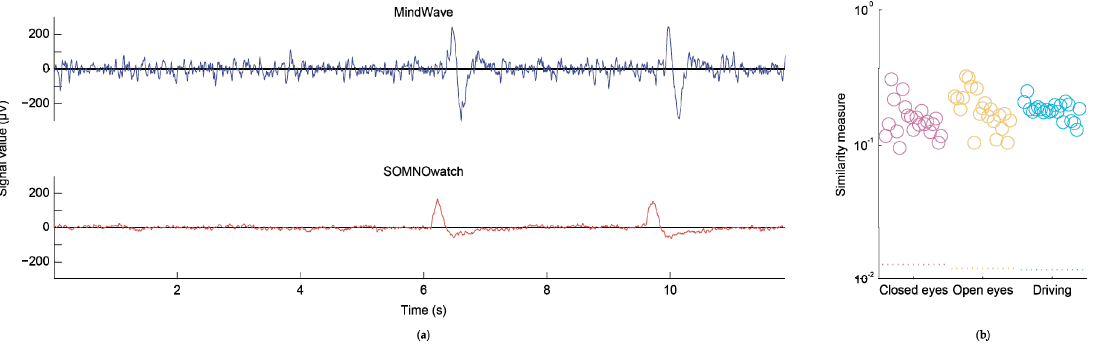
Figure 4. Comparison of temporal data series. ( a ) Left panel shows example traces of a simultaneous recording in one participant. The different noise levels and different shape of blinks are easy to observe. ( b ) The right panel shows the similarity measures (open circles) between the recordings for each participant and each of the three separate tasks (closed eyes, open eyes, driving task), as compared to a baseline value (dotted lines at the bottom). The values for each subject are displaced on the horizontal axis for representation purposes.